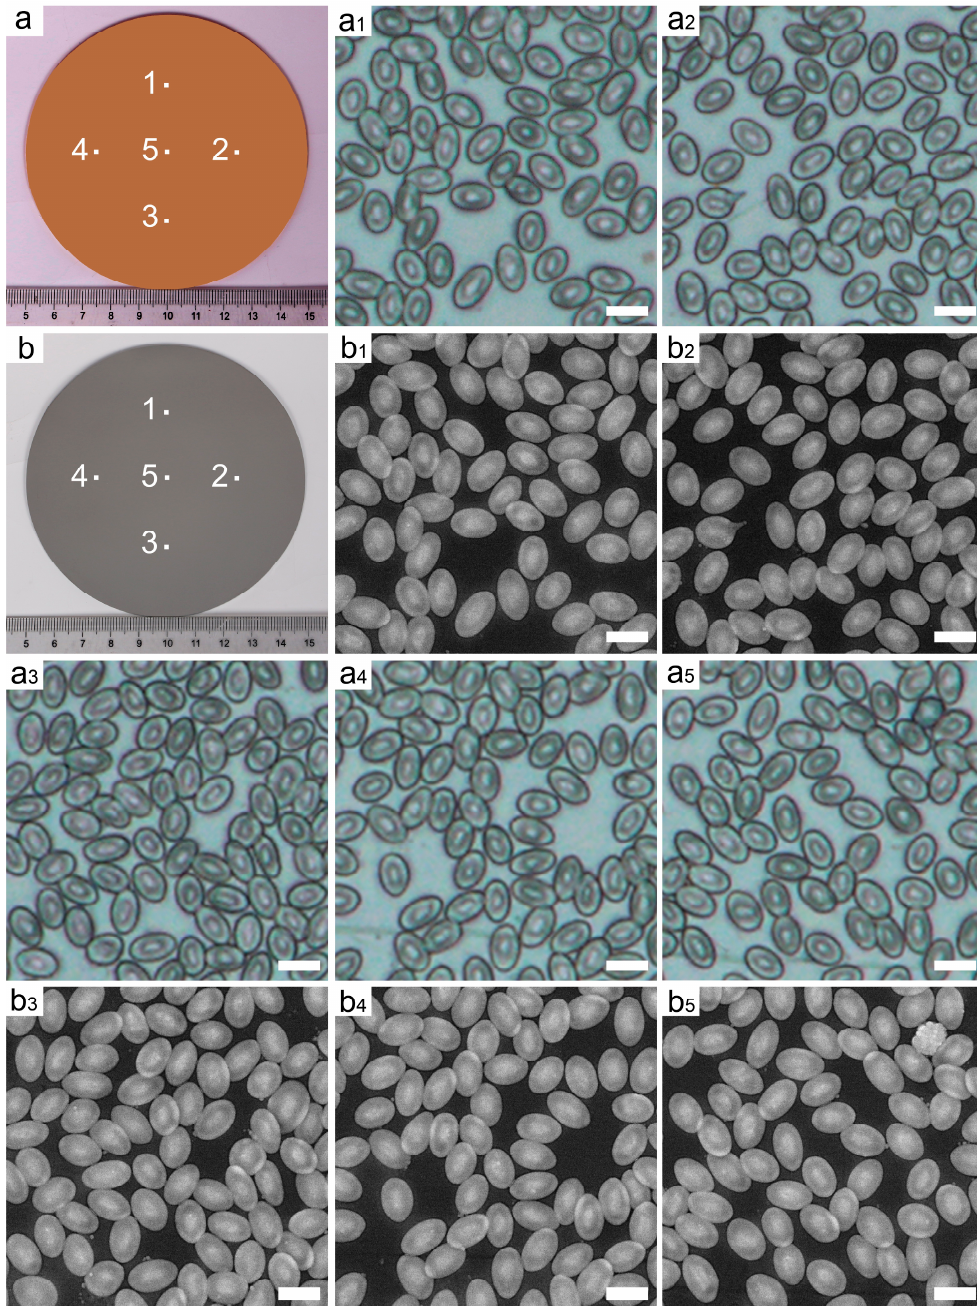
Figure 3. Comparison of the morphology of erythrocyte on quartz and actual distribution of different ratios of aluminum and tungsten metals. ( a ) Digital image of substrate formed by spin-coating of the erythrocytes on a quartz substrate. ( a1 – a5 ) Optical images taken on the marked areas of quartz substrate. ( b ) Digital image of the actual distribution. ( b1 – b5 ) BSE images of the actual distribution corresponding to the ( a1 – a5 ). All bars are 10 µ